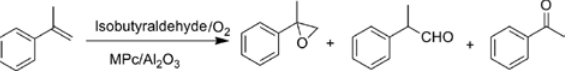
Scheme 4: Synthesis of hydratropic aldehyde by catalytic oxidation of α